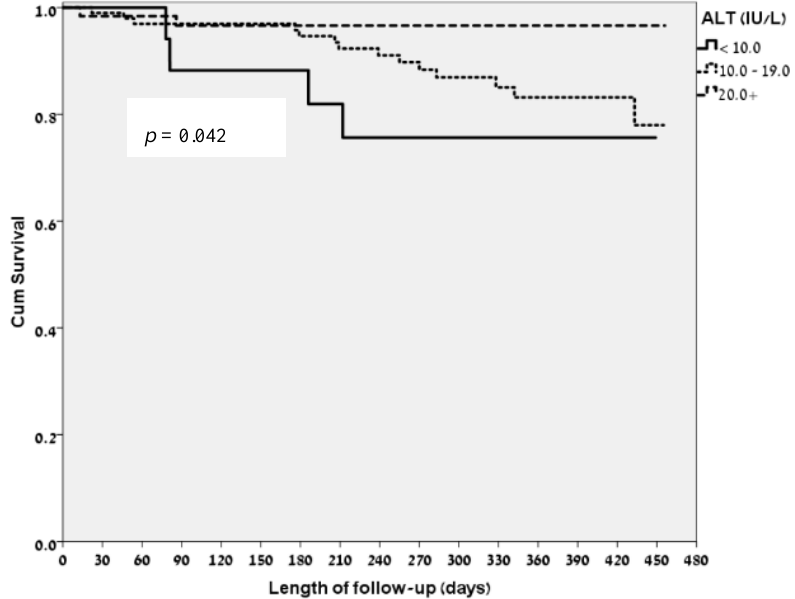
Figure 2. Kaplan-Meier survival curve according to ALT groups on admission: below 10 IU/L, between 10 to 19 IU/L and over 20 IU/L.